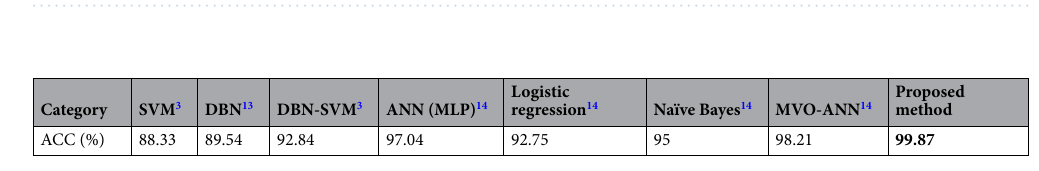
Table 11. Comparison of CART, ANFIS, and Proposed Method on KDDTest+ Dataset. Significant values are in bold.